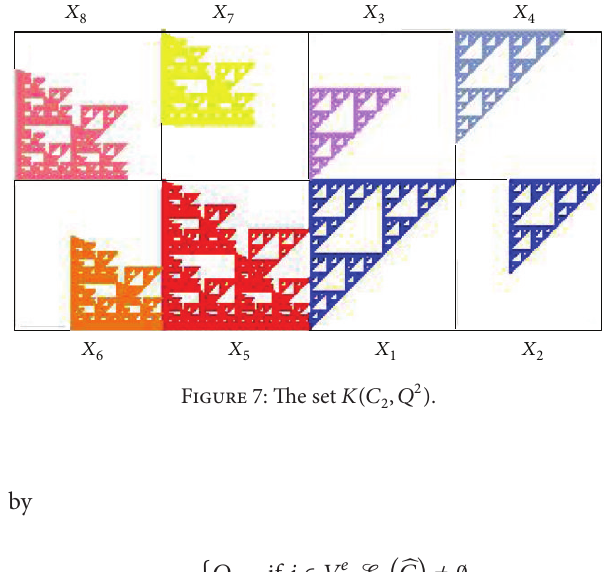
Figure 6: The set 𝐾(𝐶 2 , 𝑄 1 ) .